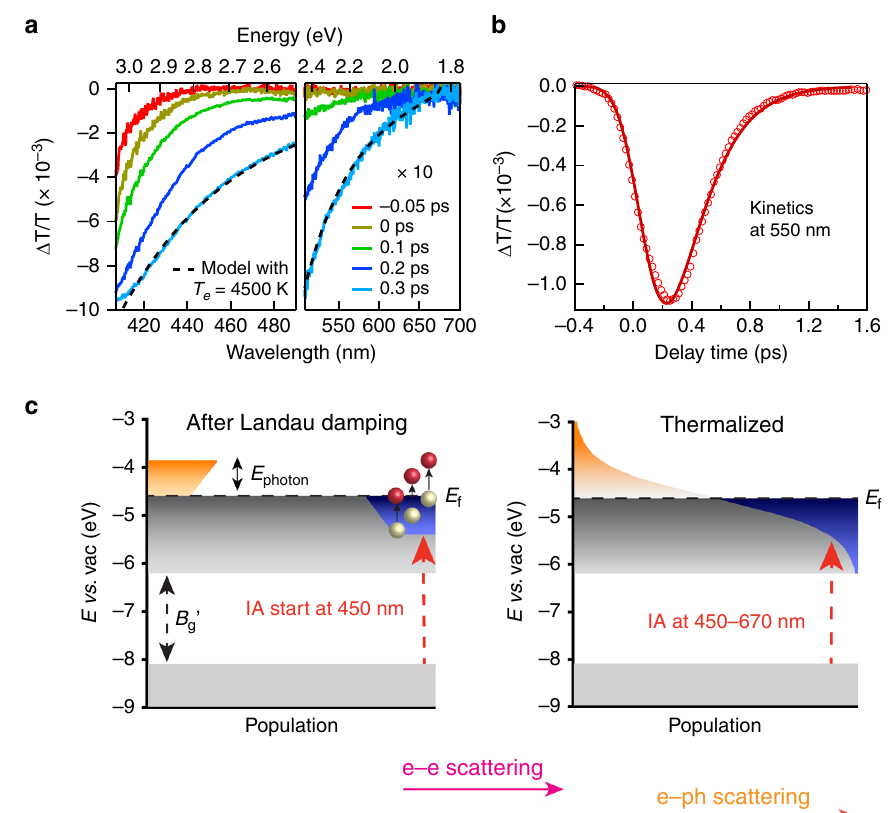
Fig. 2 Hot-electron generation and relaxation in FICO nanocrystals. a Transient absorption (TA) spectra of FICO nanocrystals (NCs) at different delay times with 400 – 490 nm in left panel and 500 – 700 nm in right panel. For better view, the amplitude of TA spectra of − 0.05 and 0 ps has been multiplied by four times and the vertical axis in right panel (500 – 700 nm) has been zoomed in by 10 times (×10). Black dashed line shows modeled spectrum at 0.3 ps with T e of 4500 K. b TA kinetics of FICO NCs probed at 550nm (empty circles) and the single-exponential fi tting (red line) of the rise and decay process. c Scheme showing carrier distribution after hot-electron generation from Landau damping (left) and after electron thermalization through e – e and e – ph scattering (right). E photon is the pump photon energy. E f is the Fermi level. B 0 is the direct bandgap after band renormalization correction. Red dashed g arrows show the induced absorption (IA) process. The gray region shows the undisturbed fi lled states. The orange and blue regions represent the excited electrons and empty states left, respectively, after Landau damping (left) and thermalization